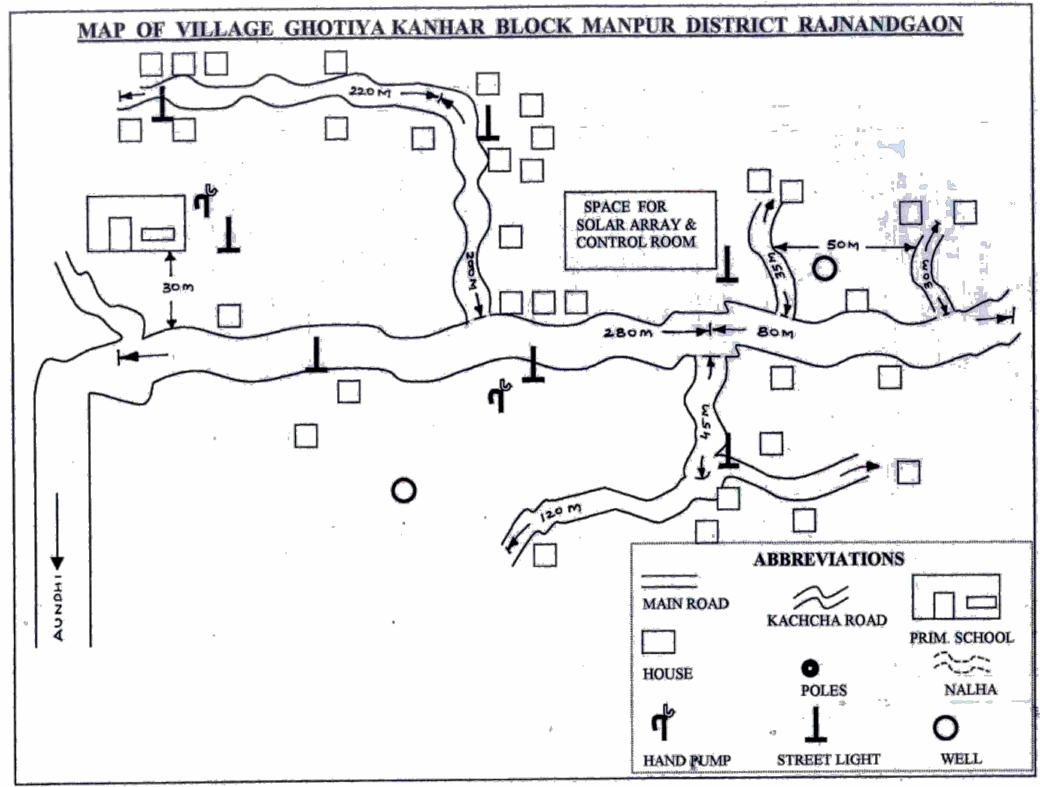
Figure 2. Map of Ghotiya village (courtesy: Chattisgarh Renewable Energy Development Authority